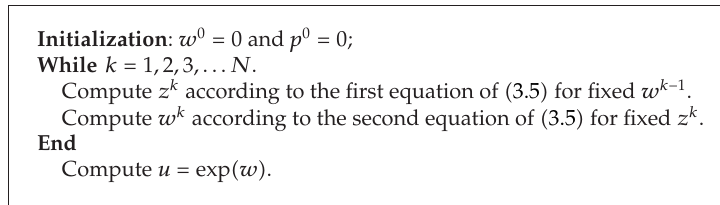
Algorithm 1: Alternating minimization algorithm for solving the model (cid:3) 3.4 (cid:4)